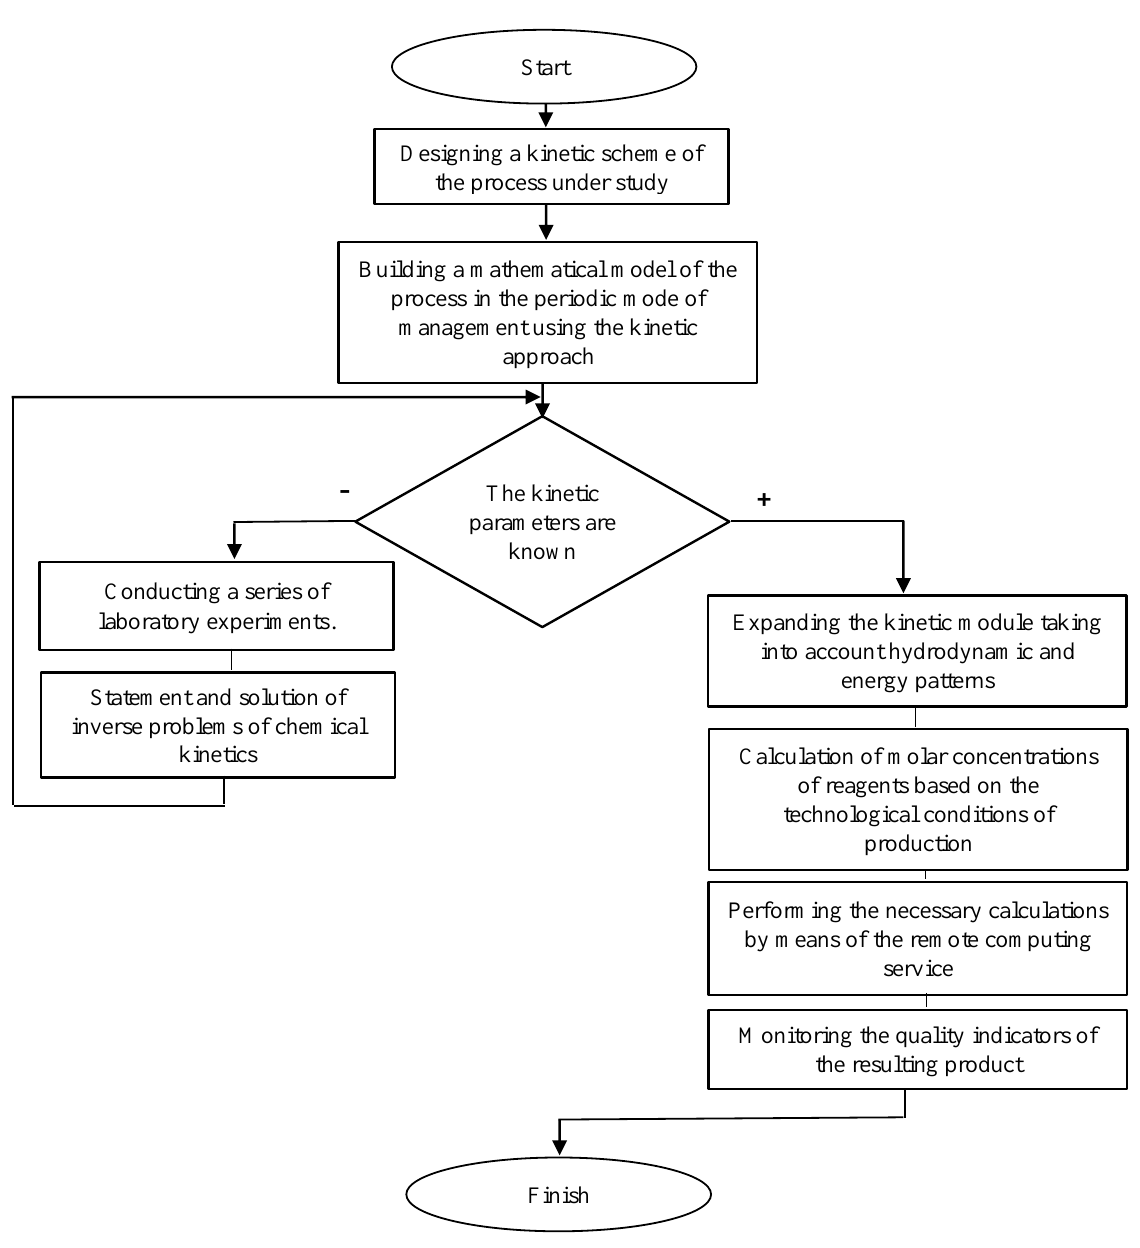
Figure 4. The main research methodology as a